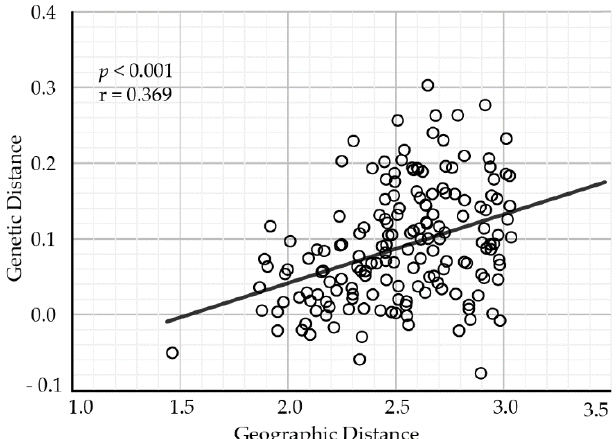
Figure 2. The relationship between genetic differentiation and geographical distance for A. chinensis populations.